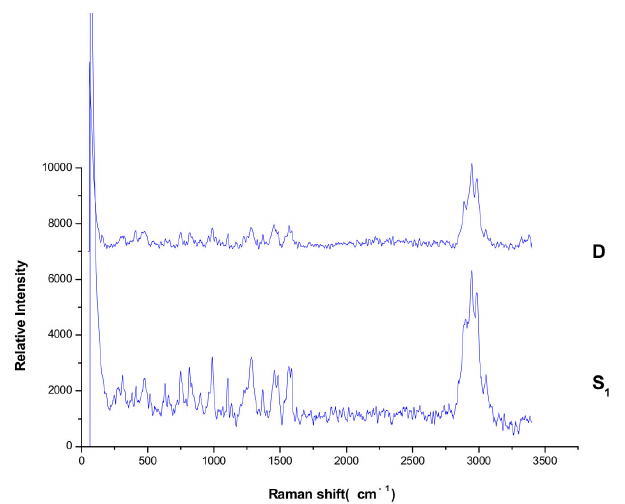
Figure 6. Raman spectrum of sample 1 by TLC-RIM. (S 1 : sample 1, D: Imidacloprid).